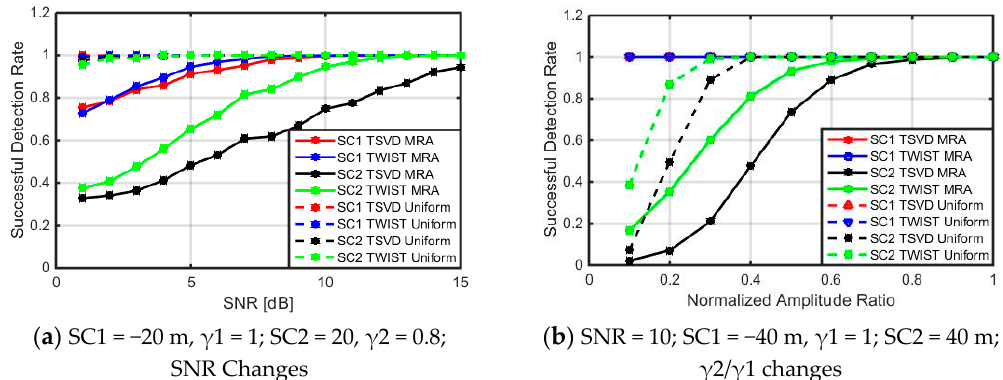
Figure 7. Successful detection rate of 1000 simulated double-scatterer pixels at different SNR levels ( a ) and normalized amplitude ratios ( γ 2/ γ 1) ( b ), where SC abbreviates from scatterer and γ is the normalized reflectivity (amplitude).